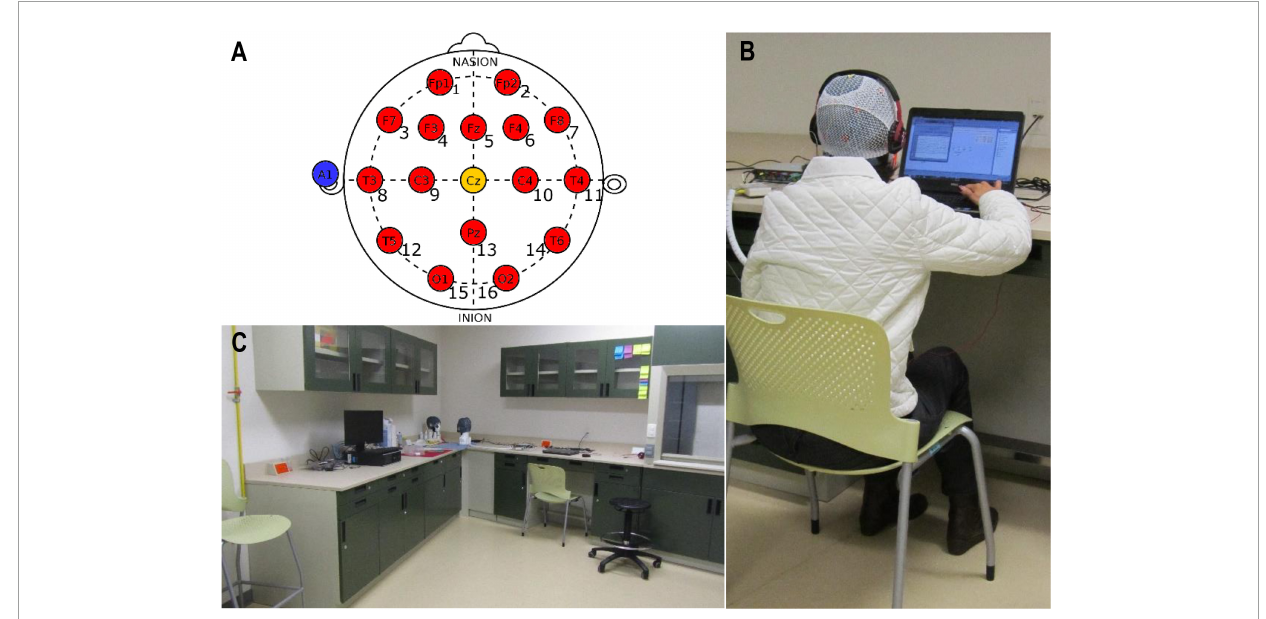
FIGURE4 EEG acquisition: (A) EEG layout of 16 channels according to the 10/20 System (red circles), along with reference A1 (blue circle) and ground Cz (yellow circle); (B) g.USBamp amplifier of EEG signals; and (C) laboratory where the experimental procedure was undertaken. This laboratory was chosen because of the low background noise, which was moreover measured before testing and was around 35 dBA. This parameter is good enough to listen the acoustic therapies and to record EEG data.